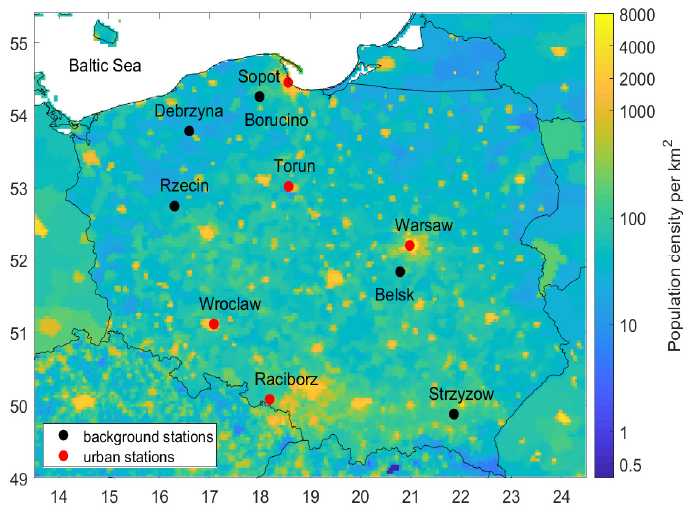
Figure 1. Locations of Poland-AOD aerosol research network stations. Red dots correspond to urban and black dots to rural (background) sites. The colour map shows population density in [km − 2 ] obtained from the Gridded Population of the World Version 4 of the Center for International Earth Science Information Network (CIESIN, https://sedac.ciesin.columbia.edu/data/collection/gpw-v4, accessed on 24 November 2021).